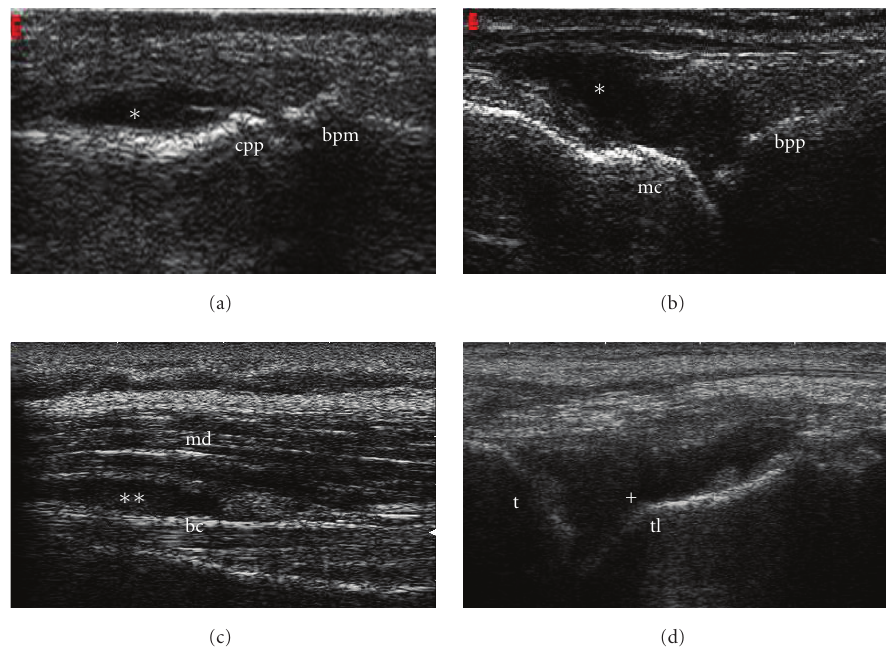
Figure 1: Longitudinal grey-scale ultrasound images of the third proximal interphalangeal joint from dorsal view with synovitis ∗ (a), the third metacarpophalangeal joint from dorsal view with synovitis ∗ (b), the shoulder joint from anterior view with subdeltoid bursitis ∗∗ , and the tibiotalar joint with e ff usion + (d). Abbreviations; cpp: Caput of phalanx proximalis; bpm: Basis of phalanx medialis; bpp: Basis of